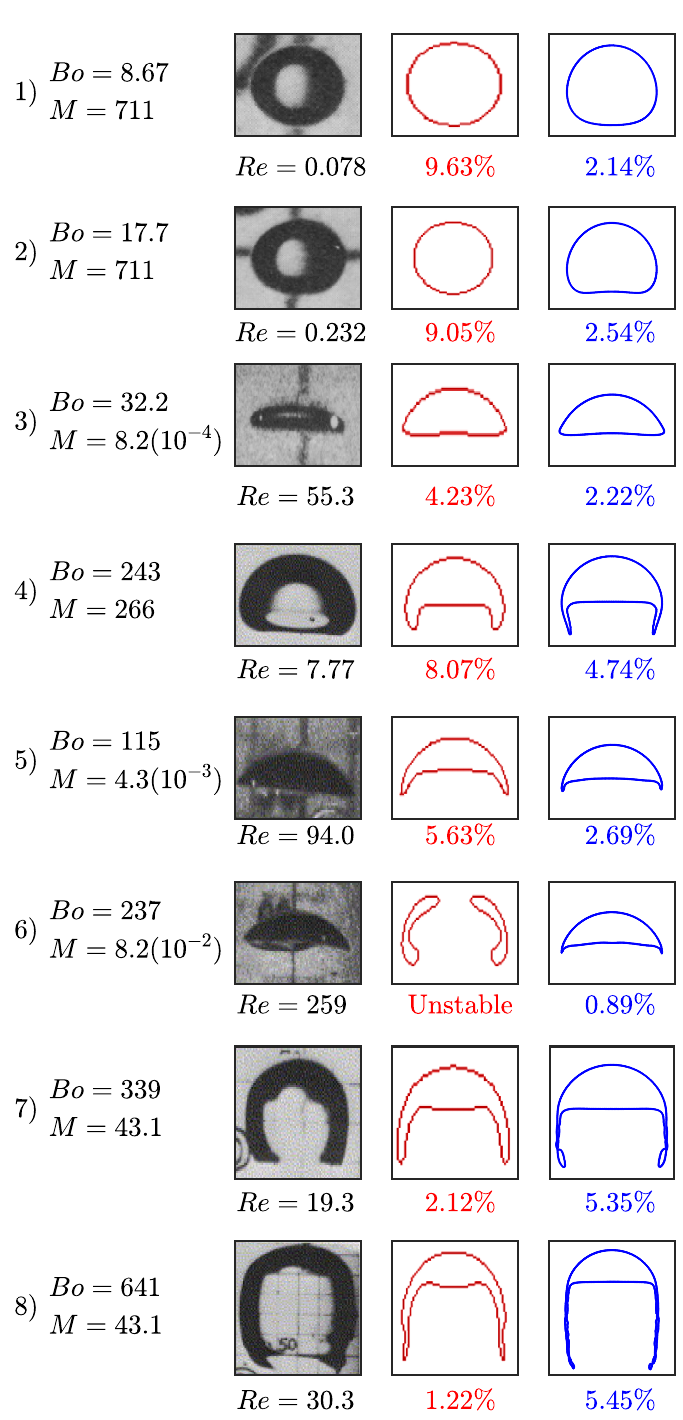
Figure 5. Bubble terminal shape and velocity in a non-reactive system: The experimental results are obtained by Bhaga and Weber, 1981 study [44], the front tracking results (red) are computed by Hua et al., 2007 using three-dimensional simulations [47], and the s-CLSVOF results (blue) are computed using two-dimensional simulations. The error percentage below the bubble figures are the absolute percent error between the experimentally measured and computed terminal velocity based on the Re